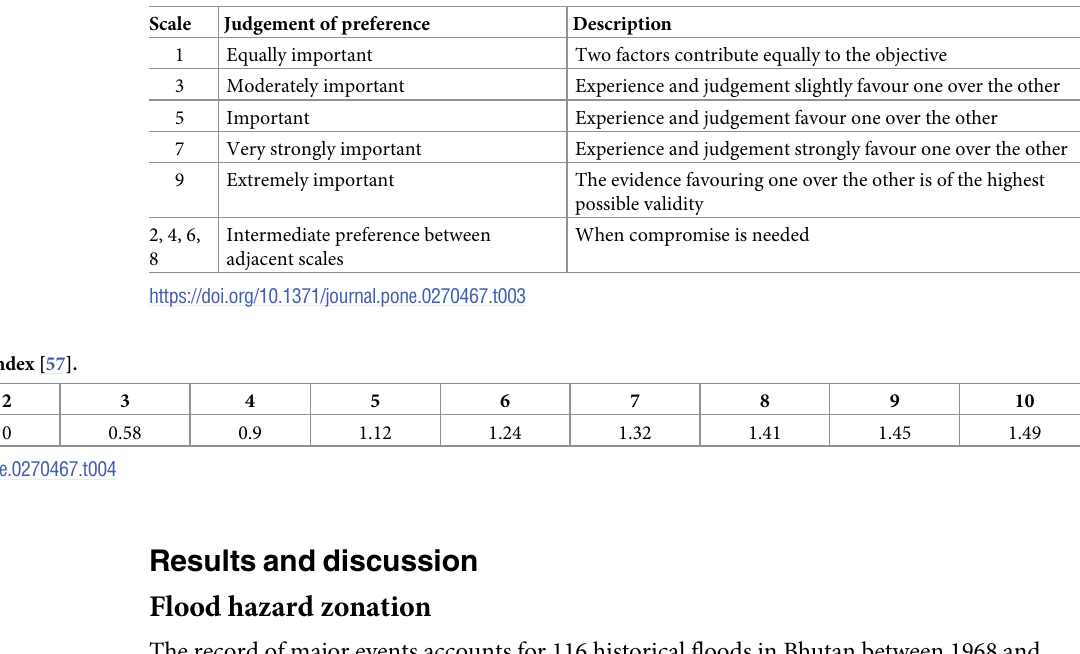
Table 3. The fundamental scale of various compared elements.